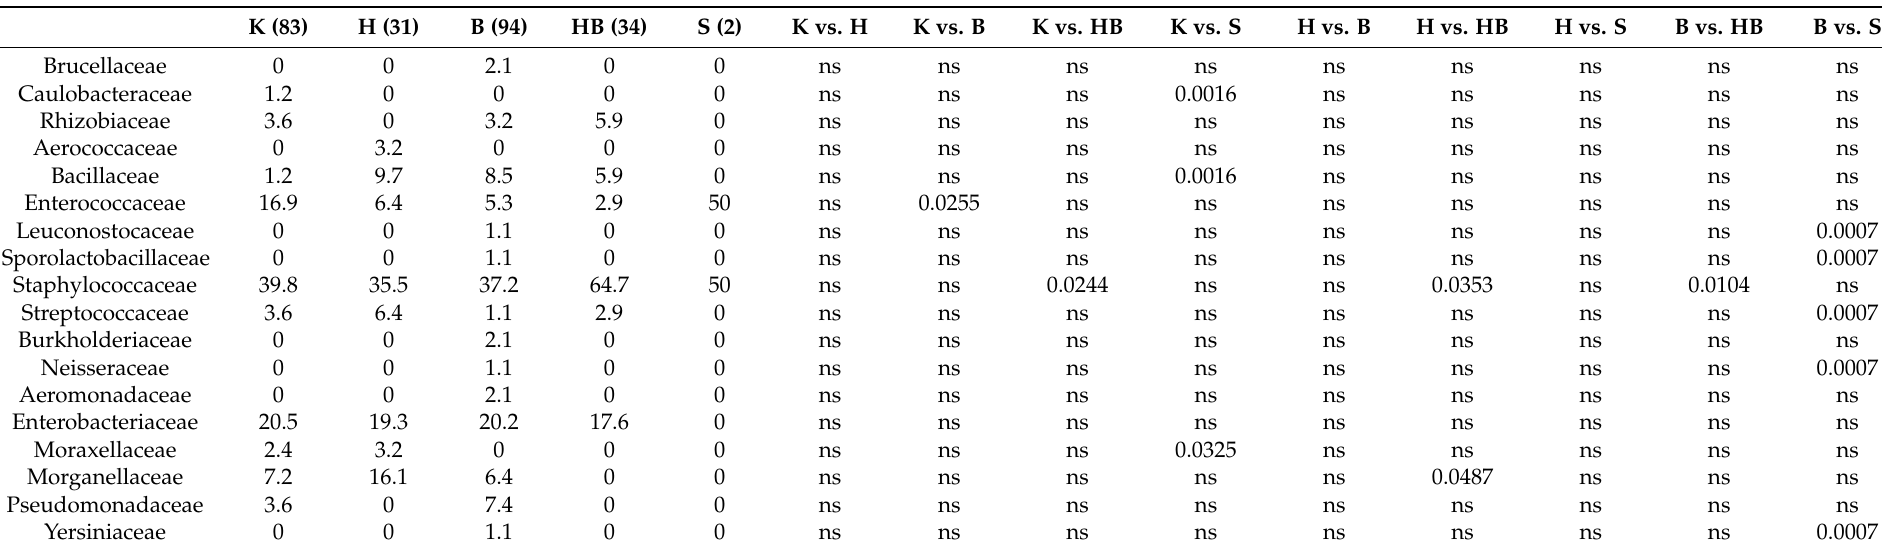
Table 6. Relative abundance (%) of cultivable bacteria at the family level according to sheltering. A chi-squared test was used to compare prevalence between